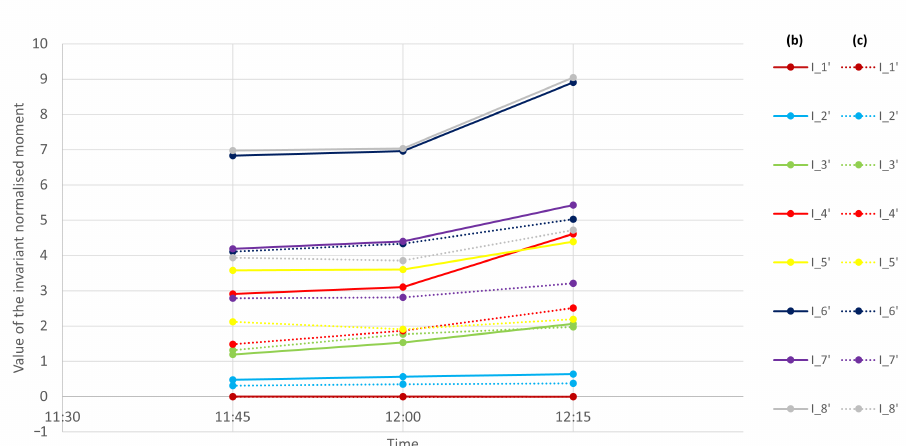
Figure 5. Dynamics of moments 10 July 2019 11:45-12.15 UTC+02:00. The values of moments from Table 2 calculated (4)–(6). Moments I (cid:48) for Figure 4b versus time are shown by solid lines, and I (cid:48) c for b Figure 4c by dashed